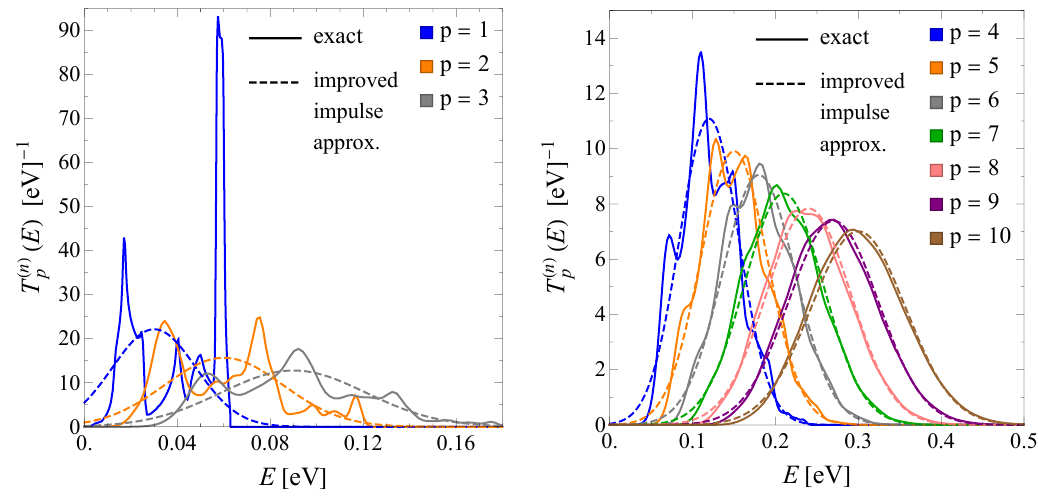
Figure 3. Comparison of the (normalized) multi-phonon terms, T ( n ) p ( E ) , obtained through the exact recursion relation in eq. (4.5) ( solid ) and through the improved impulse approximation (iaa) ( dashed ) for silicon. The improved impulse approximation performs poorly for terms with p ≤ 3 ( left panel ); however, already around p ≥ 4 the approximation provides a fairly accurate descrip- tion. Eventually, for p ≥ 10 the exact multi-phonon terms no longer show any features that differ from a Gaussian, and are well described by the improved impulse approximation ( right panel